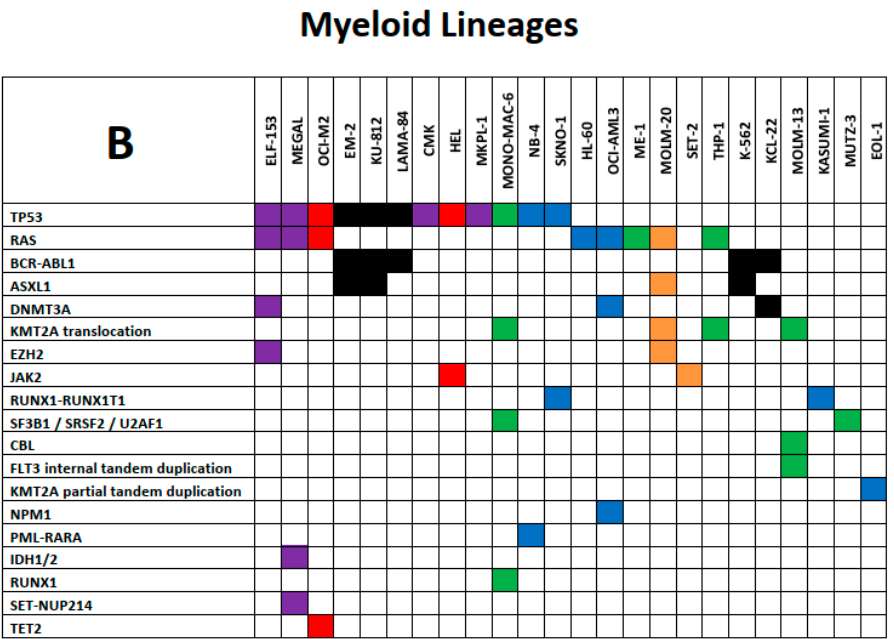
Figure 3. ( A ) and ( B ): Exemplary spectrum of selected mutational signatures in lymphoid and myeloid LL cell lines. Mosaic plot of mutant genes and chromosomal aberrations that are displayed in rows ordered by recurrence (top to bottom); cell lines are listed in columns. All mutations are annotated in the COSMIC database (hence carrying specific COSM numbers) and minimal allele frequency for mutation calling was set at < 0.01. ( A ) Color code of lymphoid LL cell lines: grey, ALCL; blue, Burkitt / B-ALL; light green, DLBCL ABC; dark green, DLBCL GCB; yellow, MCL; red, MM / PCL. ( B ) Color code of myeloid LL cell lines: blue, AML myelocytic; green, AML monocytic; red, AML erythroid; purple, AML megakaryocytic; black, CML myeloid blast crisis; orange, myeloproliferative neoplasms. The tables are not intended to be comprehensive across all aspects of leukemia–lymphoma-related alterations but instead to serve as focused high-priority areas.